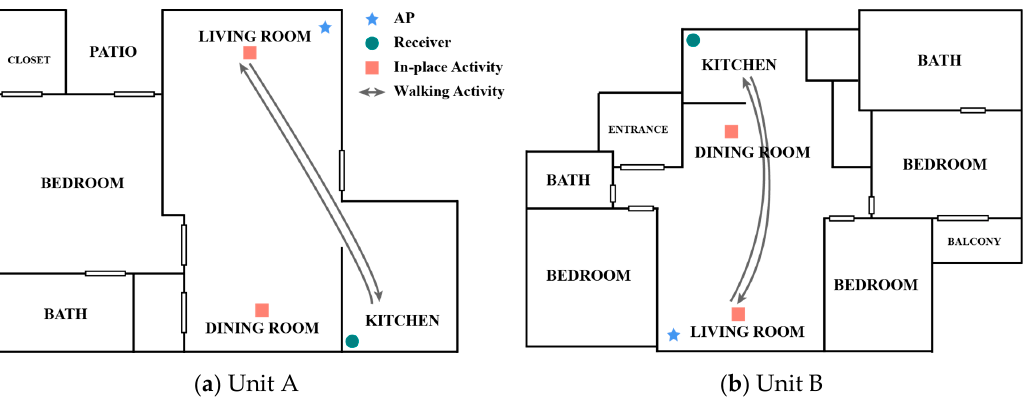
Figure 3. Floor plans for experimental test beds.